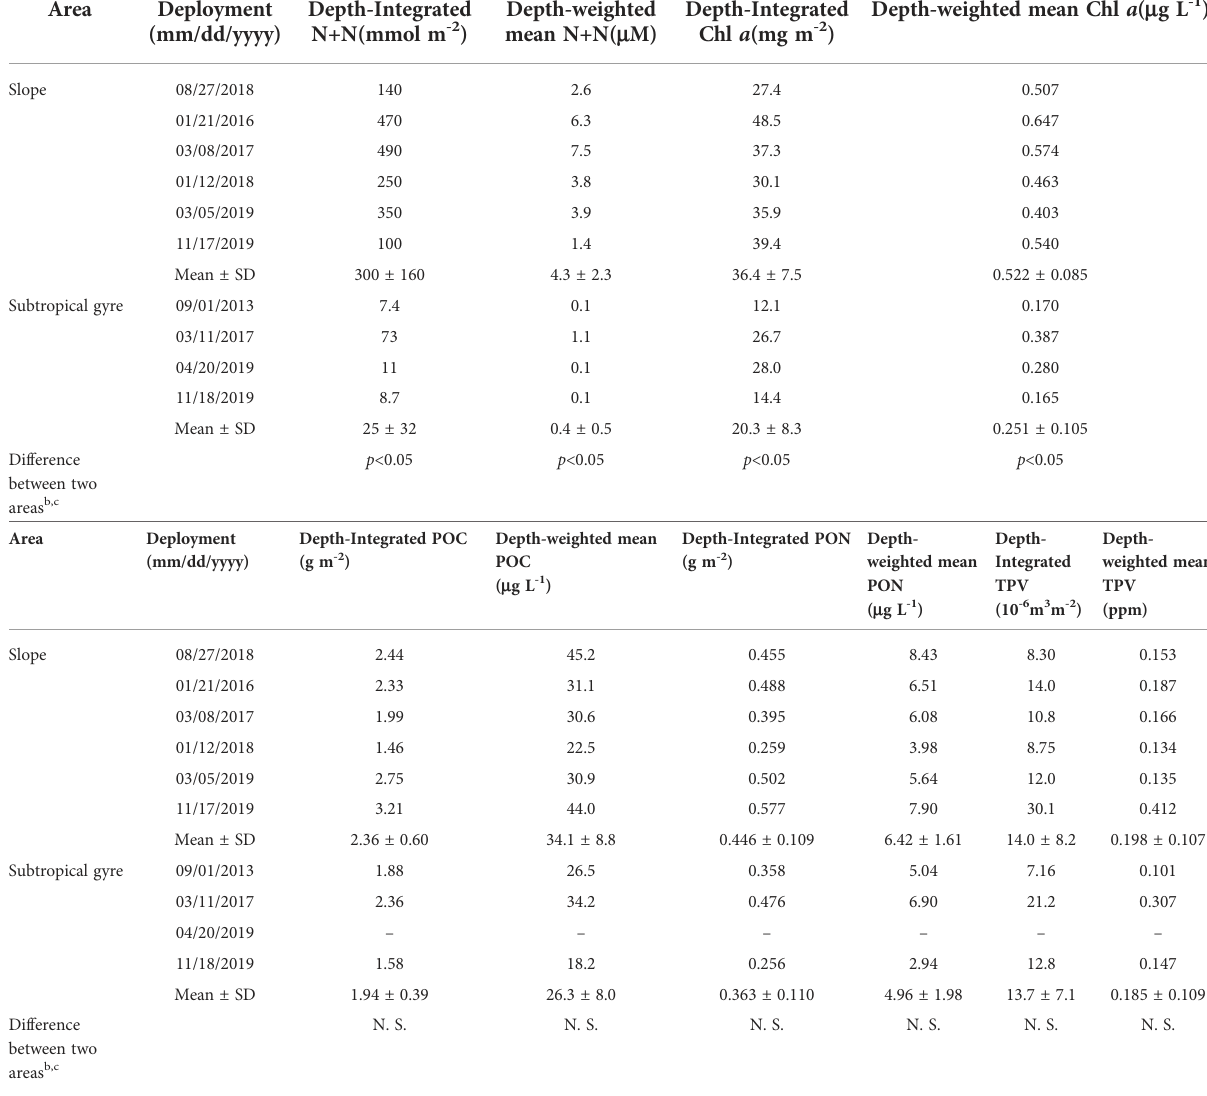
TABLE 3 Depth-integrated amounts and depth-weighted mean concentrations of sum of nitrate and nitrite (N+N), chlorophyll a (Chl a ), particulate organic carbon (POC) and nitrogen (PON), and total particle volume (TPV: 5.12 -119 m m in diameter) within the euphotic layer a .